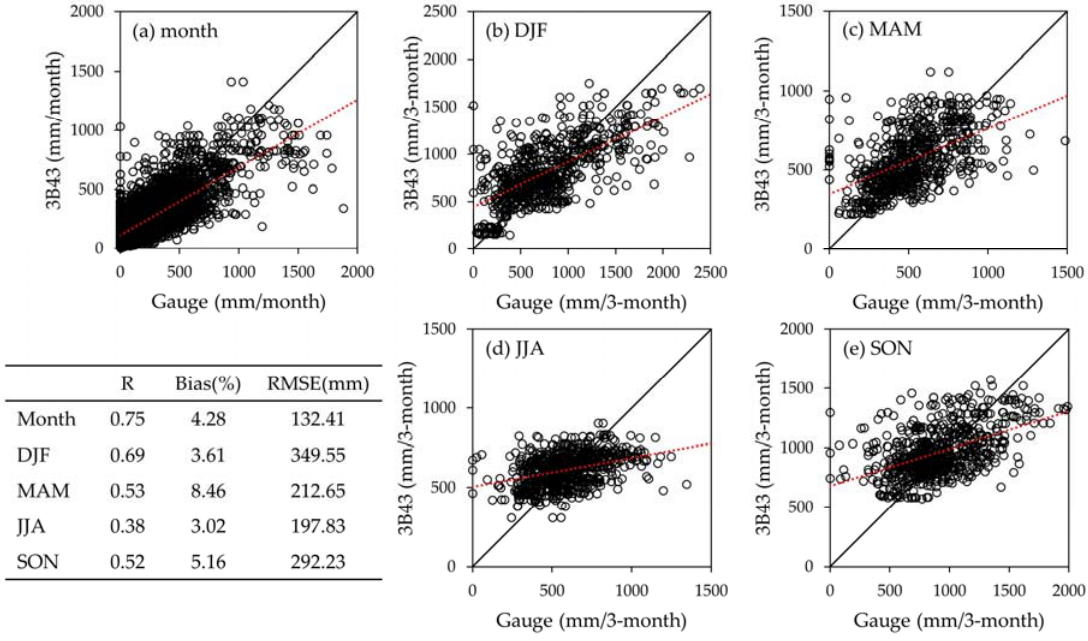
Figure 2. Scatter plots of ( a ) monthly; ( b ) December to February; ( c ) March to May; ( d ) June to August; and ( e ) September to November seasonal precipitation derived from the TMPA-3B43 and observations in the Kelantan River Basin between 1998 and 2014.